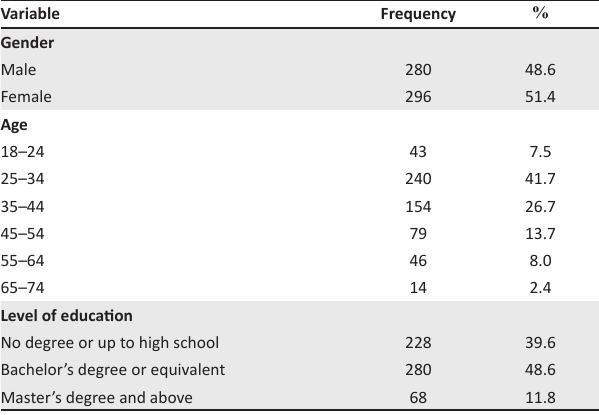
TABLE 1: Distribution of the sample